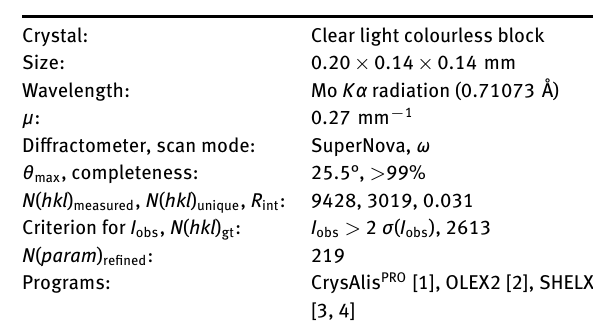
Table 1: Data collection and handling.